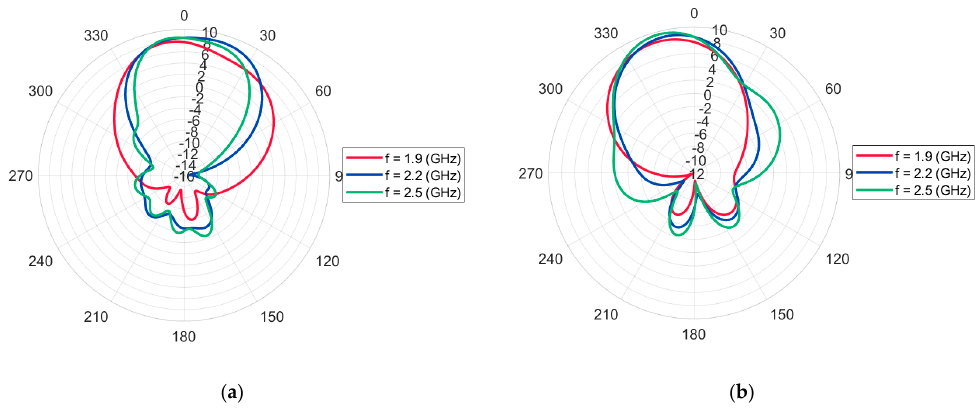
Figure 6. ( a ) Simulated | S 21 | of the E-shaped patch antenna. Comparison between the adopted configuration (with a metallic slab) and the one without the latter. ( b ) Calculated Realized Gain (dB) of the E-shaped patch antenna versus the frequency.